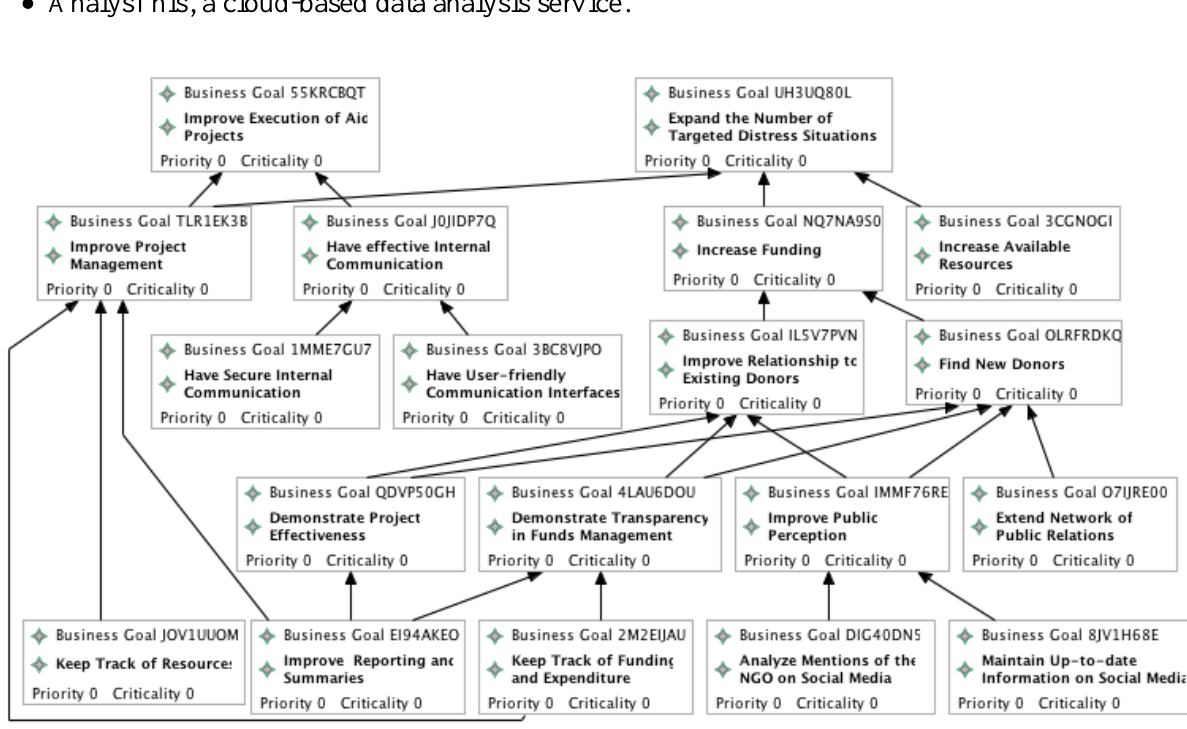
Figure 6. Goal model of the integration solution for the case of